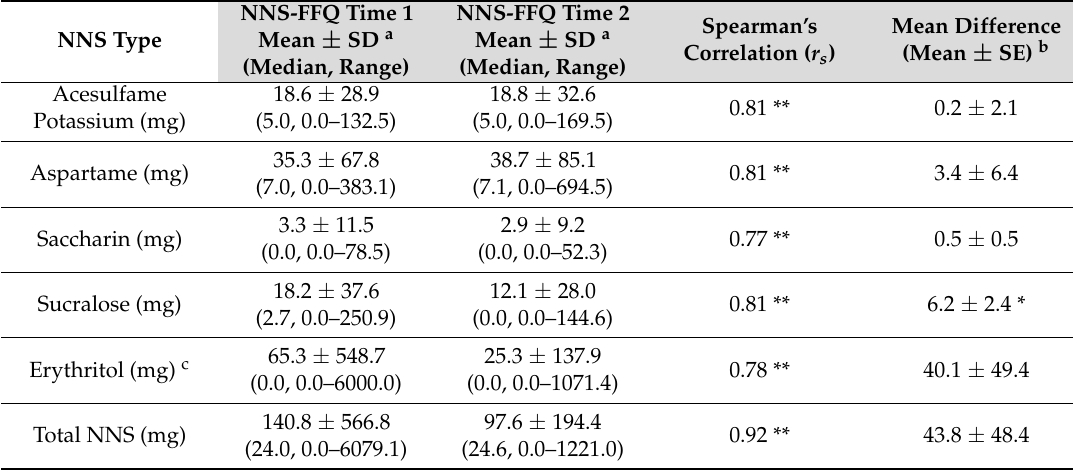
Table 3. Test–retest reproducibility of a non-nutritive sweetener food frequency questionnaire (NNS-FFQ) ( n =